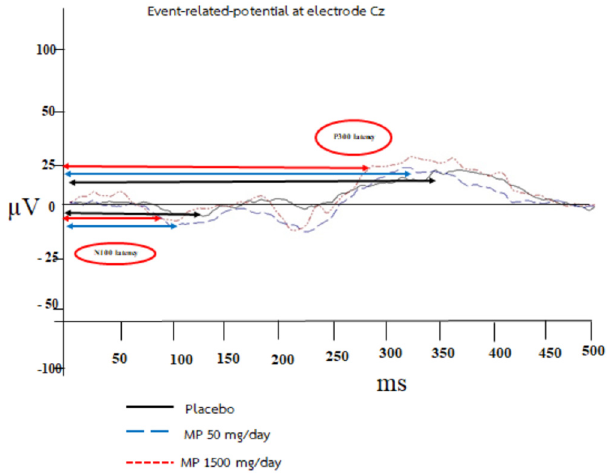
Figure 2. Representative image of event-related potential (ERP) at Cz location showing the latency and amplitude of N100 and P300 waves of the subjects who received the placebo and MP at the doses of 50 and 1500 mg/day. Table 2. The effect of various doses of the developed supplement containing the combined extract of Polygonum odoratum and Morus alba leaves on event-related potential (ERP).